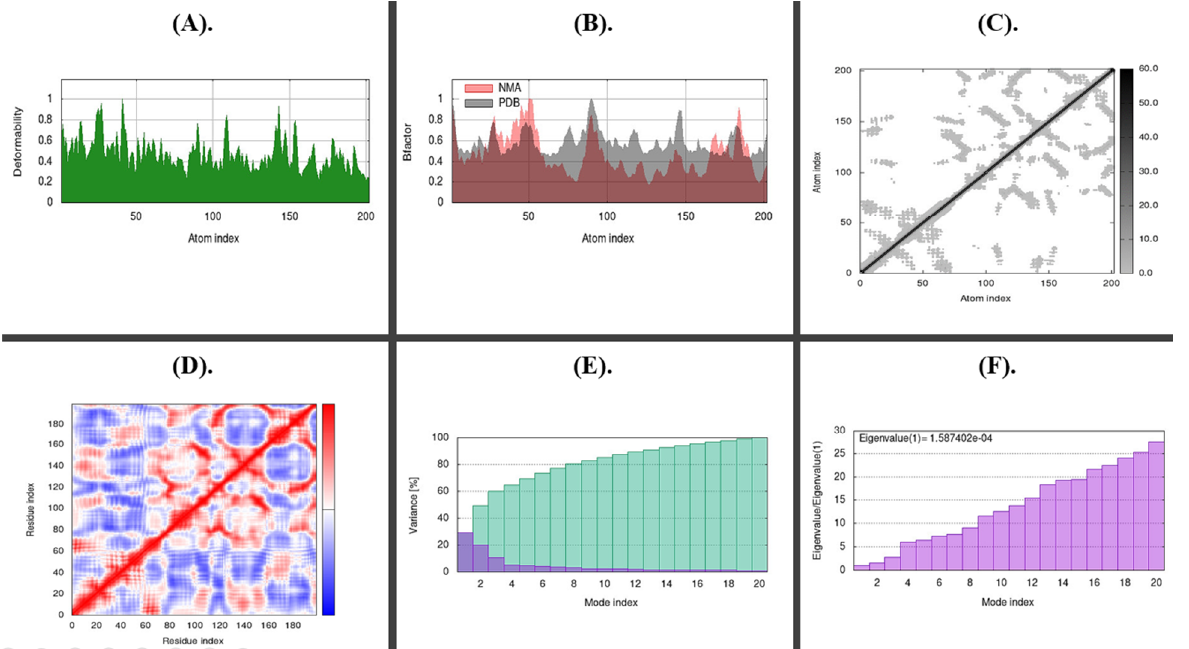
Figure 14. shows a simulation of molecular dynamics of the best-docked complex of Ruminococcin-A with ymt. ( A ). Deformability of the complex; ( B ). B-Factor graph, the plot indicates a comparative PDB plot, but there are no validated structures of our molecules on PDB ( C ). Elastic Network (Grey matter indicates stiffer region). ( D ). Covariance Map: correlated ( red), uncorrelated (white), or anti-correlated (blue) motions ( E ). the eigenvalue plot illustrates the minimum energy required to deform the complex ( F ). Variance.